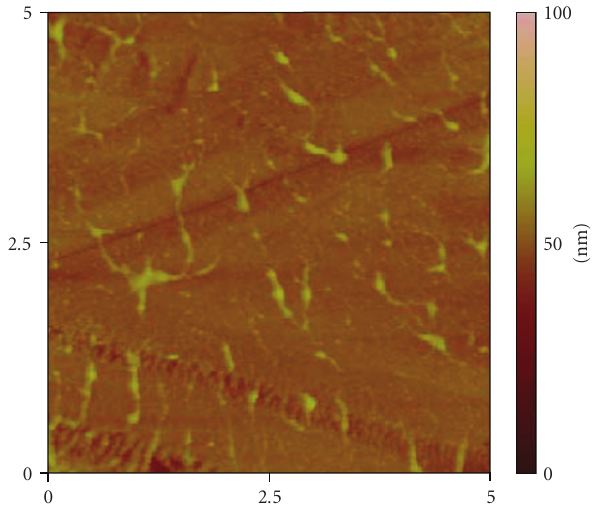
Figure 4: AFM image (5 × 5 μ m) of M-PEDOT:PSS (0.1 wt%) film.